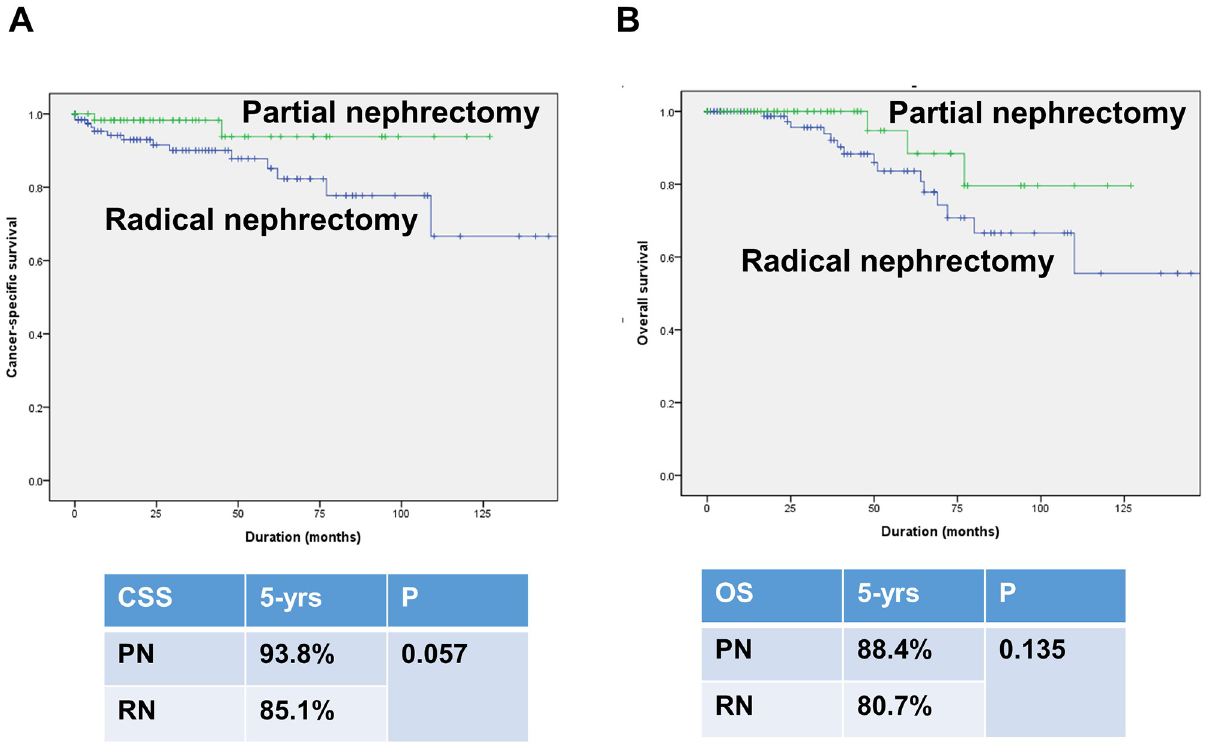
Fig 3. Kaplan-Meier curves for cancer-specific survival (A) and overall survival (B) in octogenarians according to the surgery type.